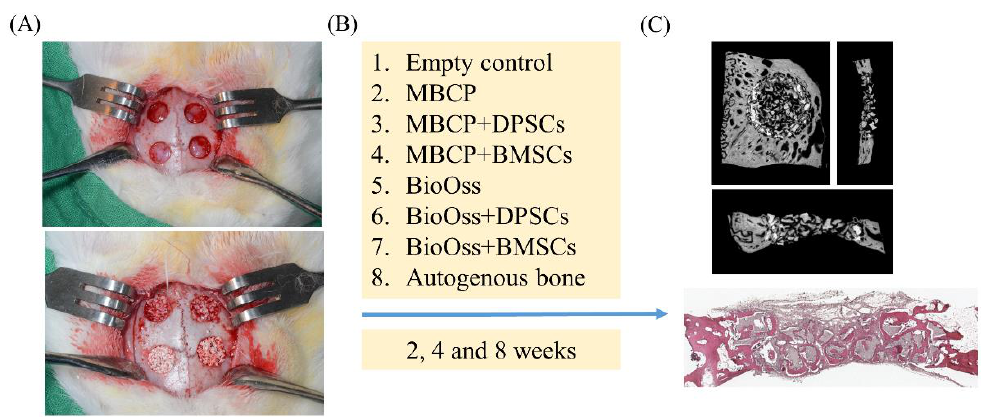
Figure 2. Characteristics of both the DPSCs and BMSCs.